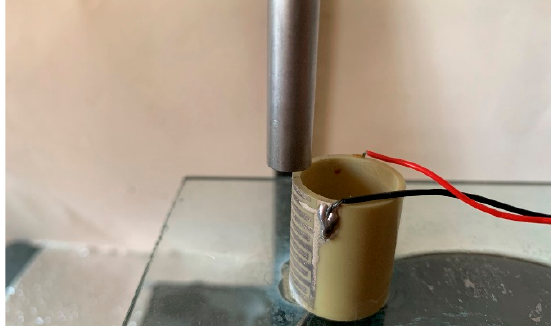
Figure 11. The laser head and sample.